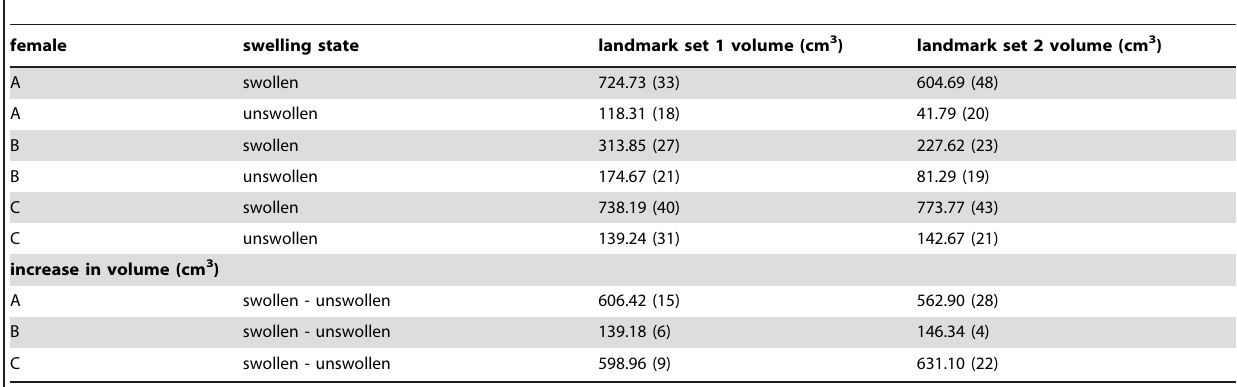
Table 5. Comparison of volume results of Barbary macaque anogenital swelling volumes obtained by the landmark setting of two